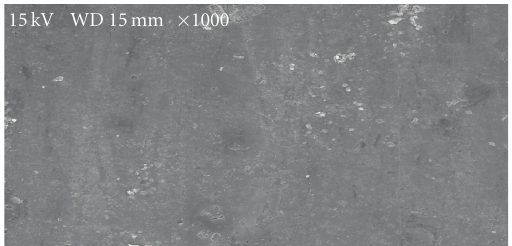
Figure 10: SEM Photograph of mild steel immersed in 1N HCl solution containing an optimum conc. (6% v/v) of Ocimum sanctum .